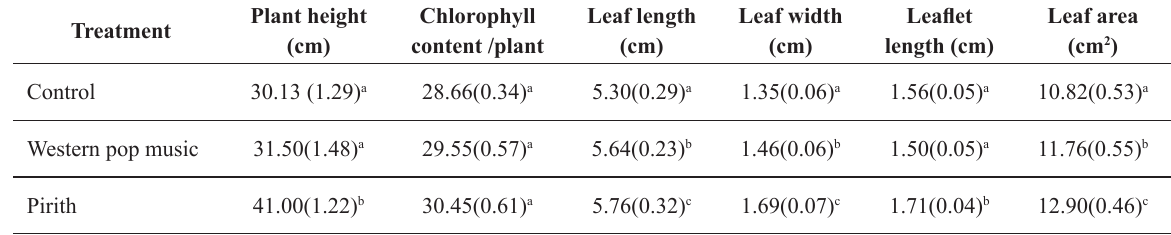
Table 1: Summary statistics of the parameters measures across different treatments. Similar letters in column indicated that there is no statistically significant difference at p